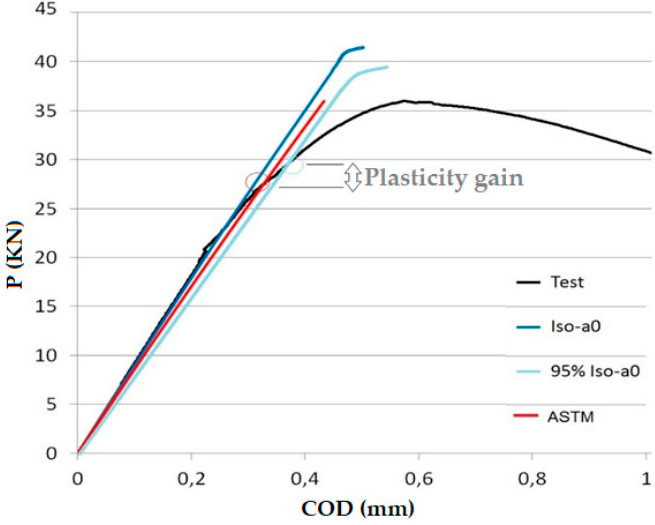
Metals 2019 , 9 , x FOR PEER REVIEW Figure 9. Proposal for zones for di ff erent HIC mechanisms in a FAD diagram merging IG with IG + TG. Figure 9. Proposal for zones for different HIC mechanisms in a FAD diagram merging IG with IG + TG.